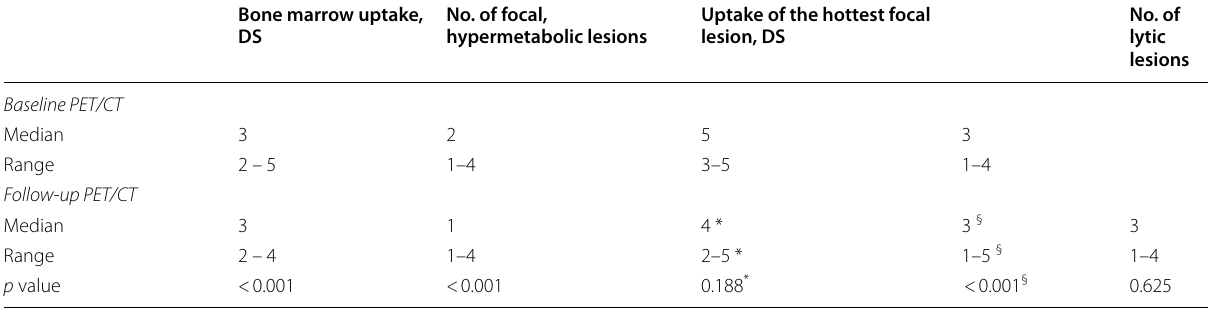
Table 3 Descriptive statistics including median values and range of PET/CT variables after application of IMPeTUs at baseline (before treatment) and follow‑up (after ASCT and before maintenance) scanning